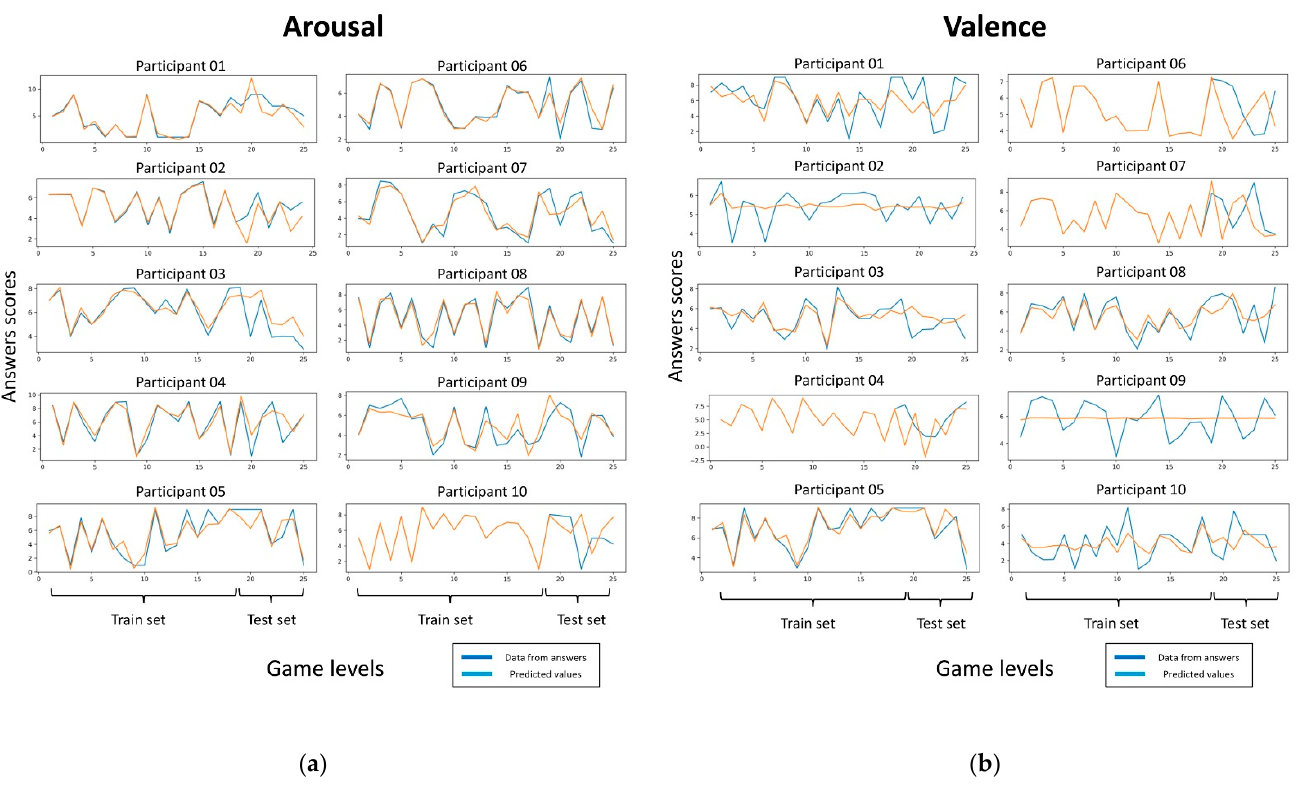
Figure 4. Performance of Bayesian ridge regression predictions for arousal and valence scores. ( a ) Arousal score values and predictions over the train and the test set. ( b ) Valence score values and predictions over the train and the test set.